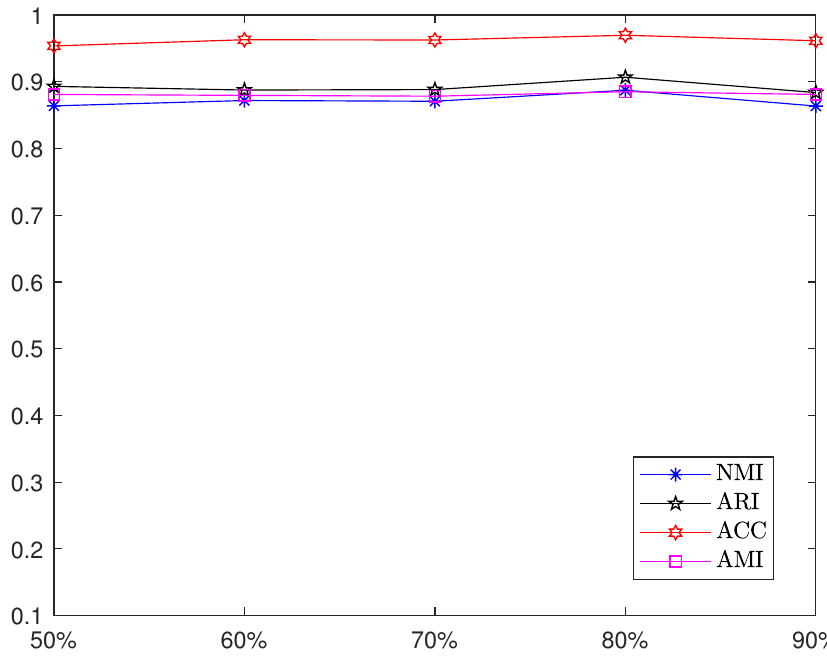
Figure 13. Results of Wine by